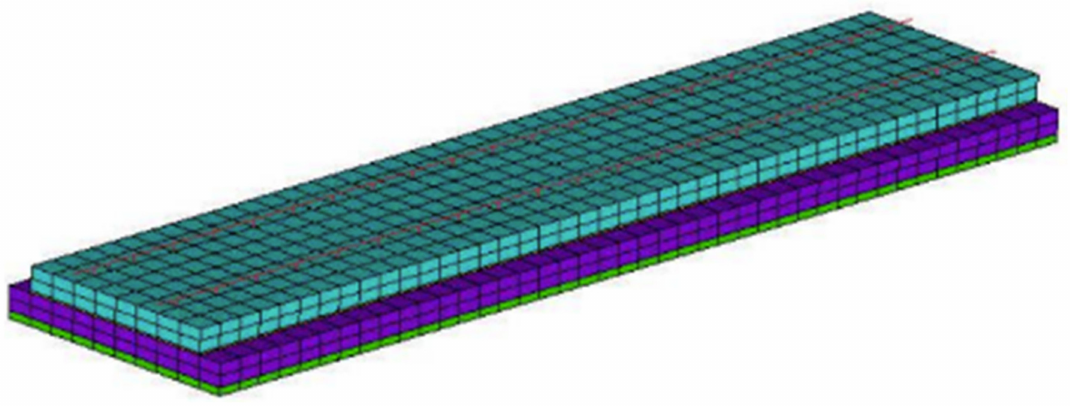
Figure 3. Finite element slab-track models with (from top to bottom) rails and rail pads (red), track plate (turquoise), mortar/gap layer (orange), base layer (violet), and Winkler support (green). Table 1. Parameter variation in the slab track (Site G, standard parameters are underlined). Parts Parameters Values Rails bending stiffness of the rails (UIC60) mass per length of the rails Slab track stiffness of the rail